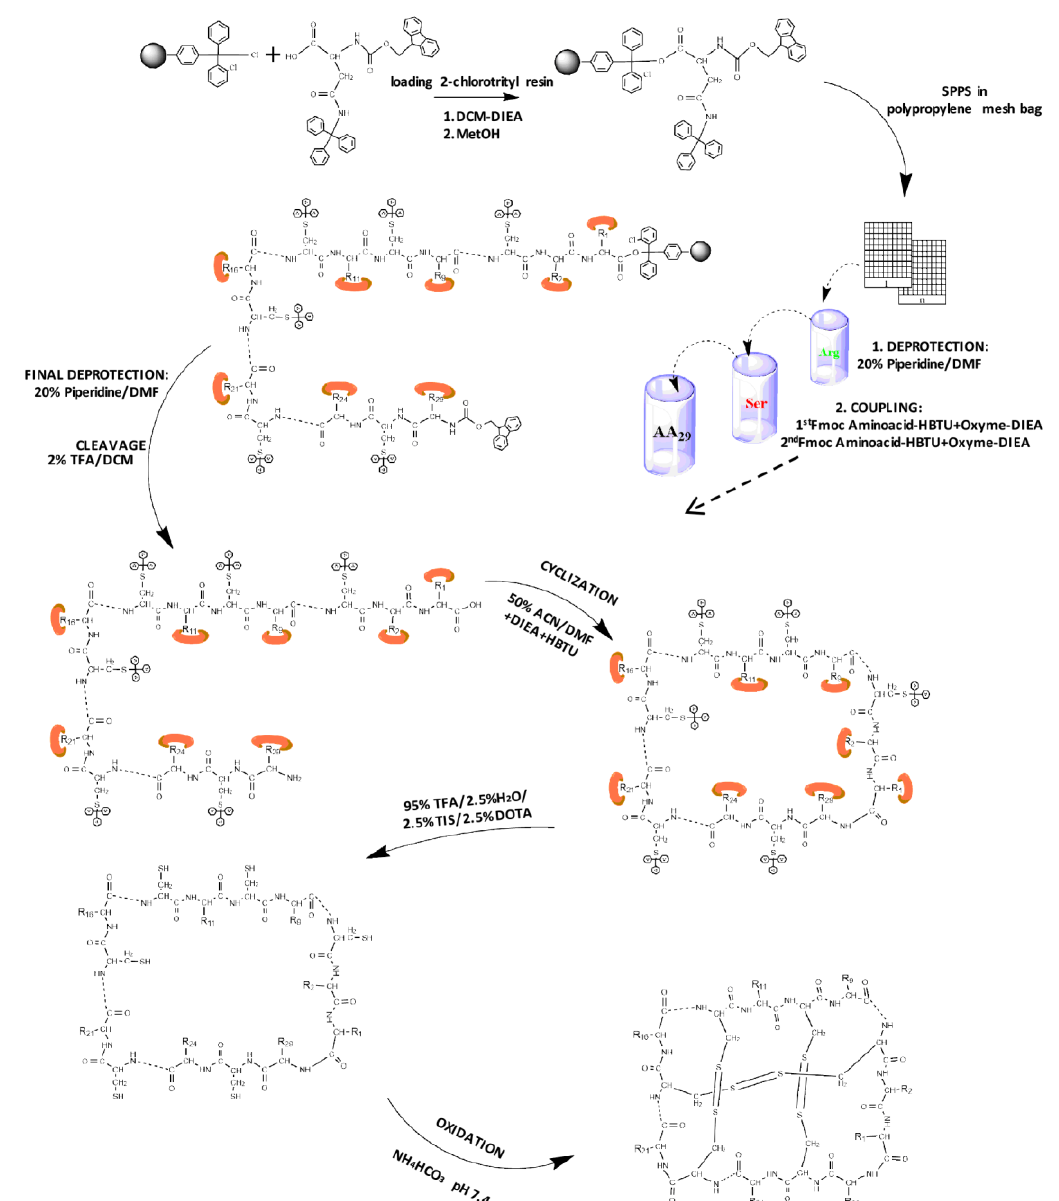
Figure 1. Chemical synthesis strategy. Schematic representation of synthetic route for SPPS of cyclotide. The VarvA backbone (cyclo(GLPVCGECFGGTCNTPGCSCDPWPMCSRN)) was